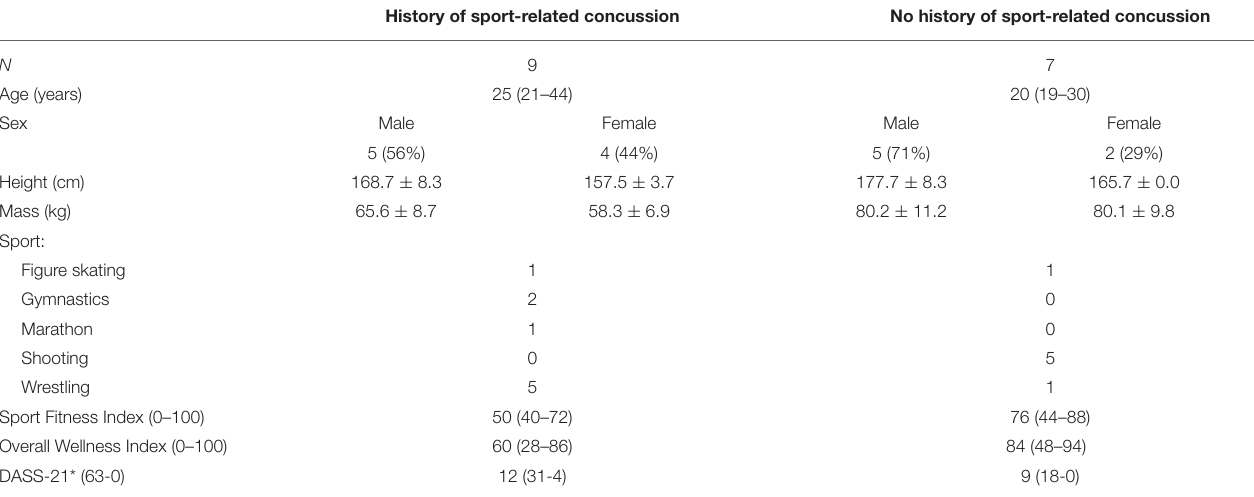
TABLE 1 | Cohort characteristics; height and mass: mean ± standard deviation; age and survey scores: median (range). History of sport-related concussion